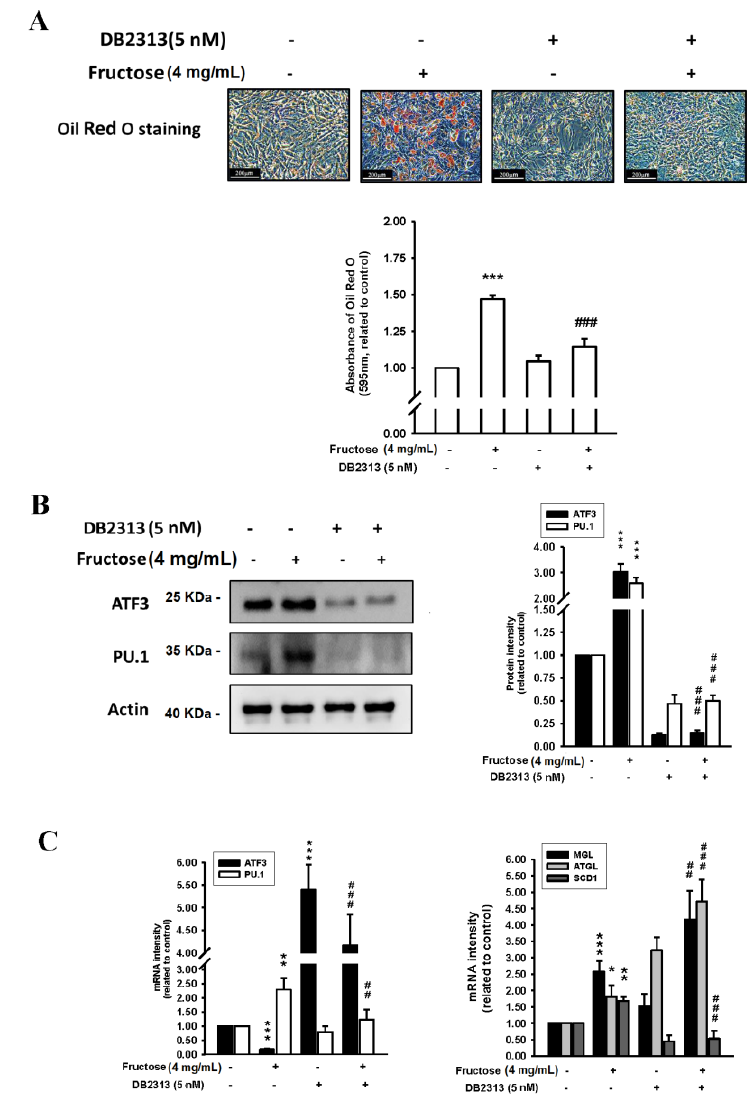
Figure 3. Effects of fructose concentration (4 mg/mL) with and without a PU.1 inhibitor (DB2313, 5 nM) on ( A ) triglyceride levels by measuring ORO staining, ( B ) ATF3 and PU.1 protein levels, and ( C ) ATF3, PU.1, MGL, ATGL, and SCD1 mRNA levels in adipocytes in vitro. N = 6, the results from